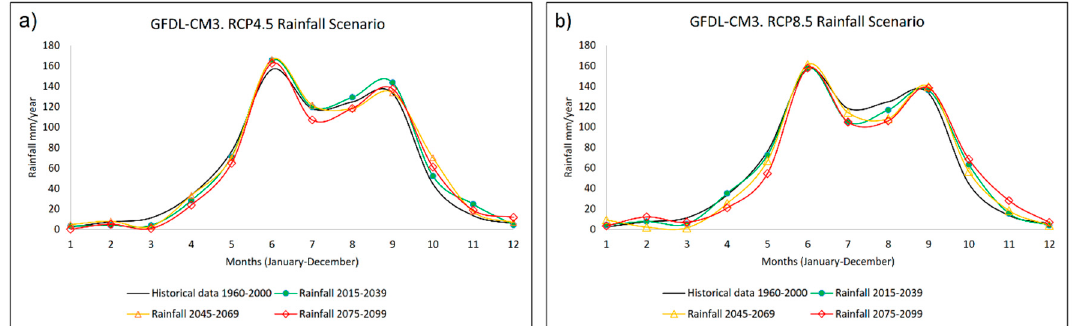
Figure 4. ( a , b ) Normal monthly P for historical and future climate projections under RCP4.5 and RCP